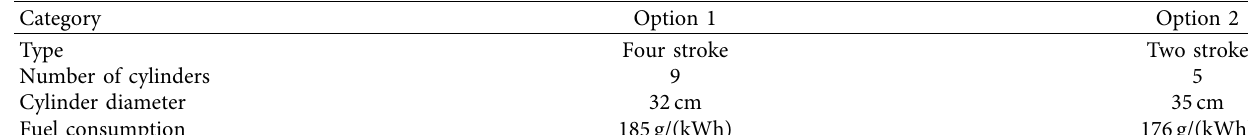
Table 3: Technical parameters of diesel